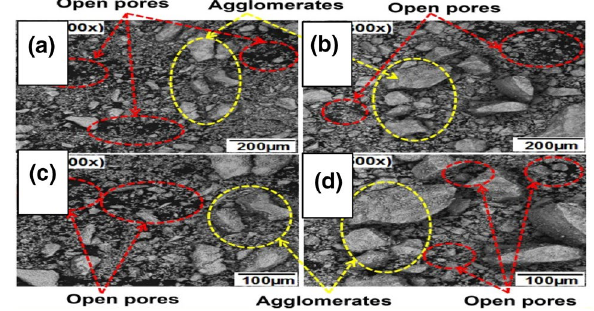
Fig. 11 Scanning electron micrographs HAp showing pores on a CB 200 µm b NB 00 µm c CB 100 µm and d 100 µm